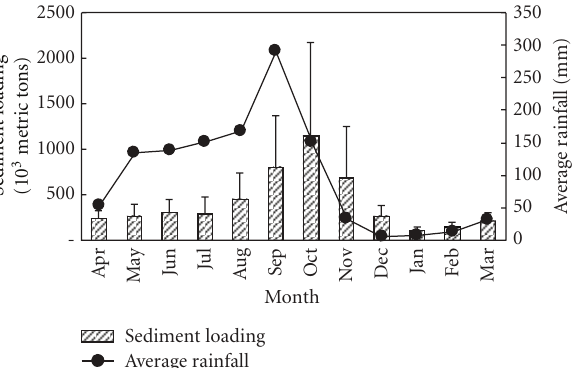
Figure 3: Average monthly sediment loading at Nakhon Sawan from 1976 to 1993 excluding the data of 1987 (Error bars denote standard deviation) and average rainfall (mm) within the Chao Phraya River basin between 1942 and 1988 (cited from